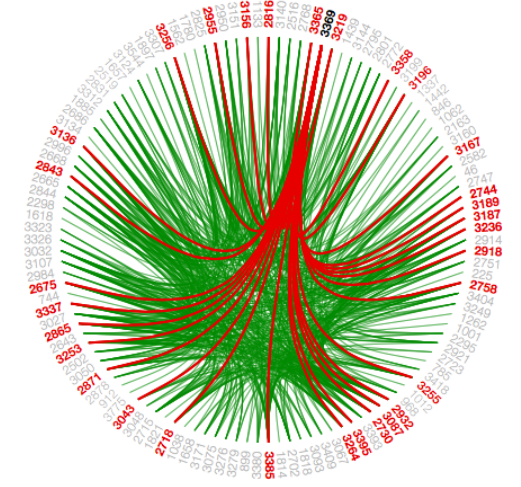
Figure A8. Representation hierarchical edge bundling visualization with high tension.